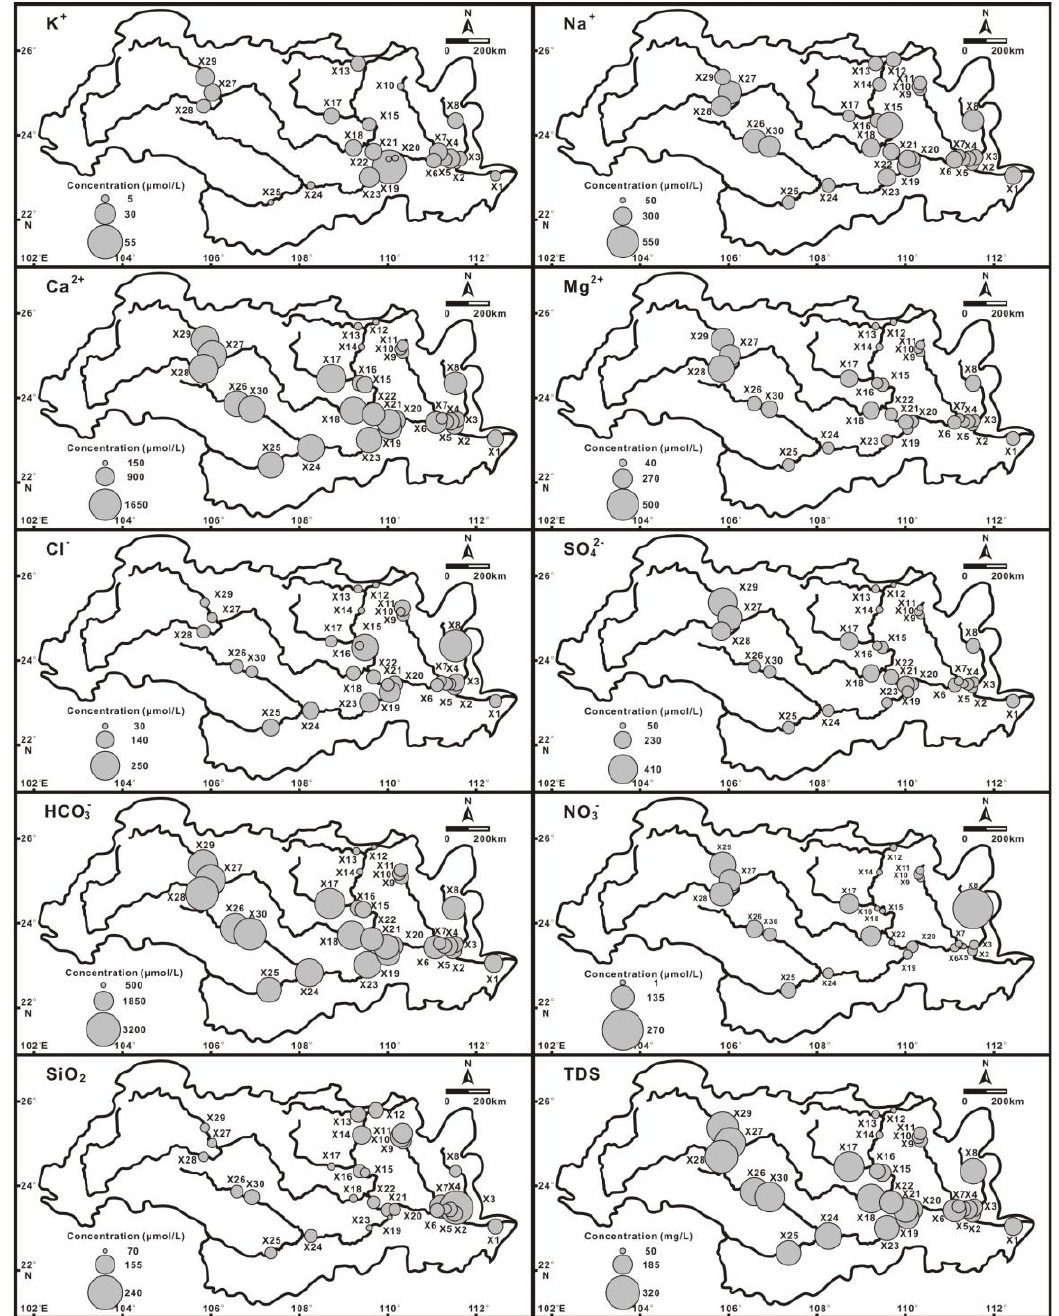
Figure 2. Spatial distributions of weighted averages of major ions, dissolved silica, and total dis- solved solids (TDS) in the Xi River Basin. solids (TDS) in the Xi River